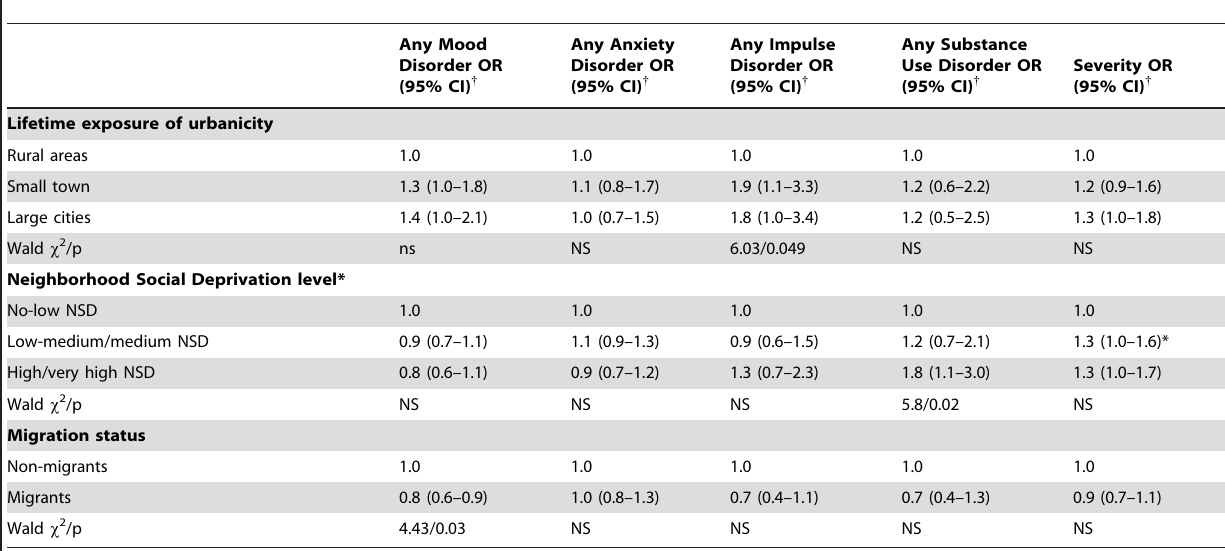
Table 4. Associations (odds-ratio) of lifetime exposure of urbanicity, neighborhood social deprivation level, and migration status with 12-month DSM-IV/WMH-CIDI